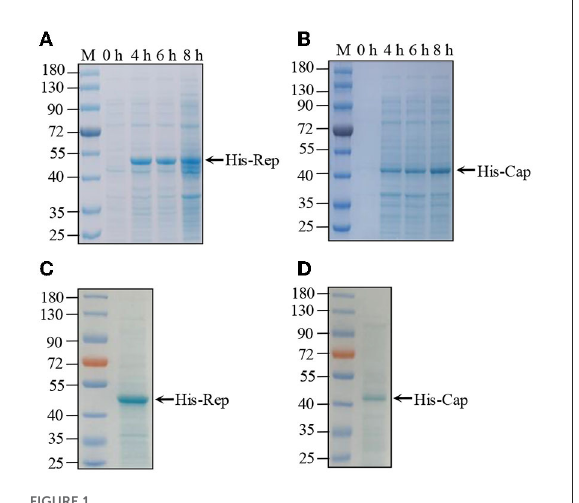
FIGURE1 Purification of PCV4 Rep and Cap protein. (A,B) His-tagged recombinant protein expression and purification. pET-32a-Rep (A) and pET-32a-Cap (B) recombinant plasmid individually transferred into BL21pLyss Escherichia coli were induced expression by IPTG at different times. Induced protein samples were subjected to SDS–PAGE and Coomassie brilliant blue staining. (C,D) Subsequently, expressed His-tagged Rep (C) and Cap (D) recombinant proteins were purified by Ni-NT assay, which were further analyzed by SDS–PAGE and Coomassie brilliant blue